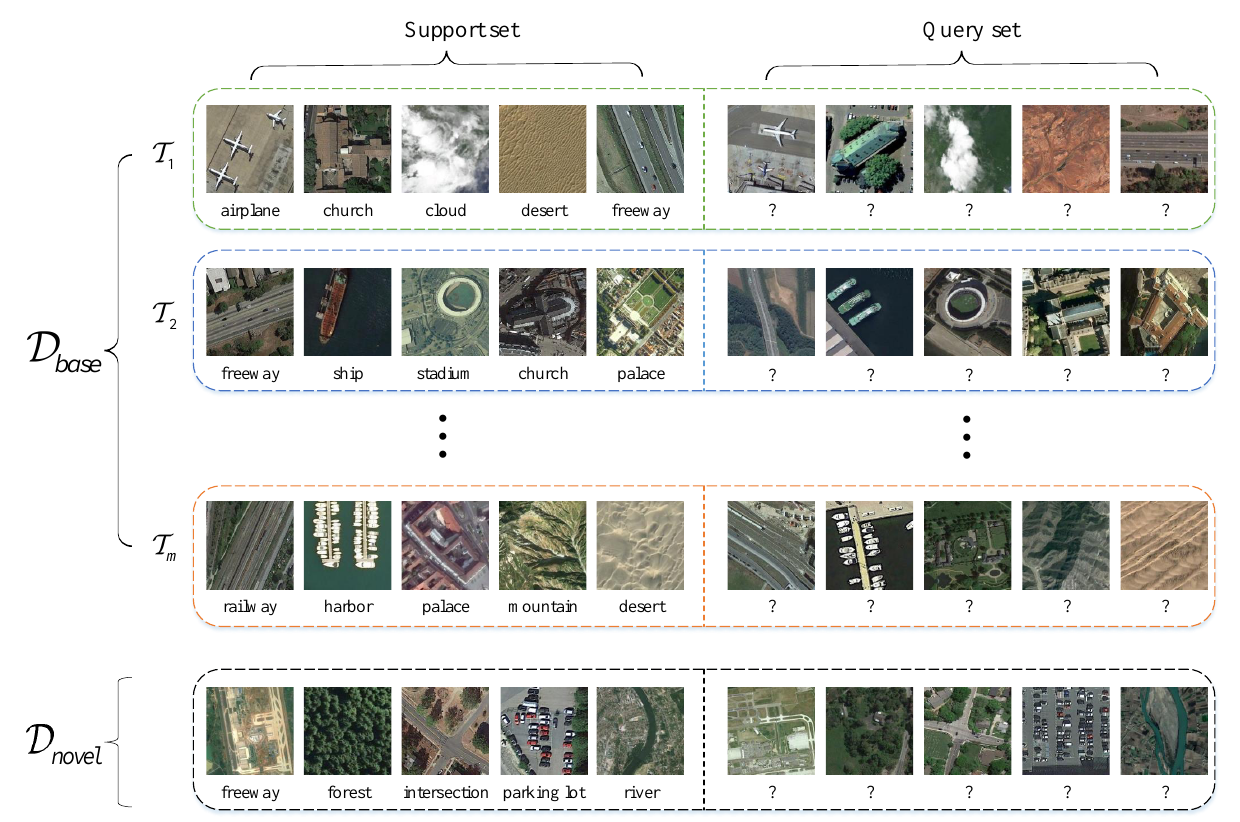
Figure 3. Illustration of data partition of remote sensing scene classification in the 5-way 1-shot setting.